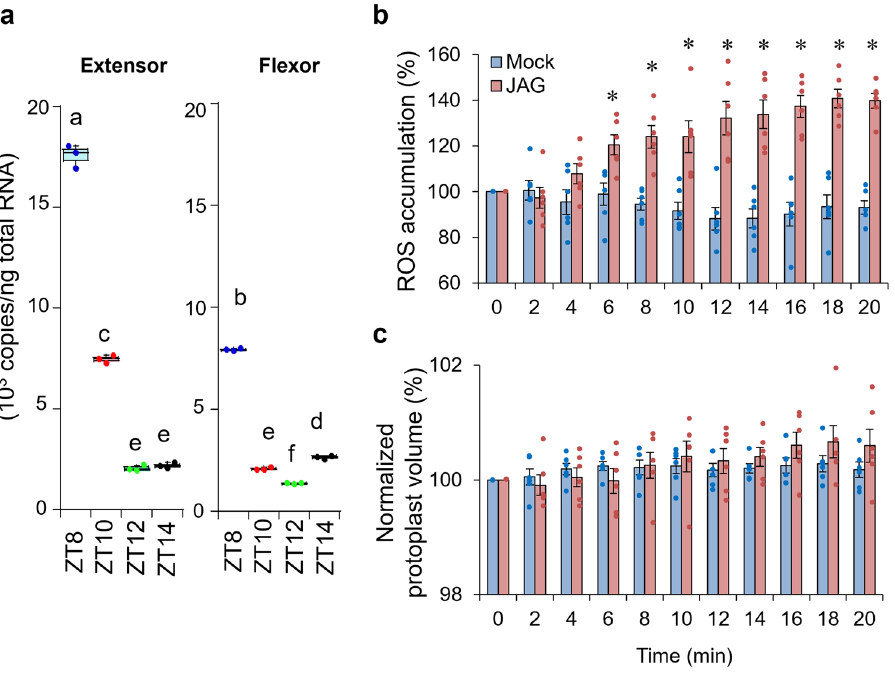
Figure 5. Effects of JAG on extensor protoplasts that did not express SPORK2. ( a ) The expression of SPORK2 gene during ZT 8–14 in extensor and flexor cells. All data points are shown as dot plots (n = 3). Different letters indicate significant differences (SNK post-hoc test, P < 0.05). ( b , c ) Time course of 12-hydroxyjasmonic acid glucoside (JAG)-induced ( b ) cytosolic ROS accumulation and ( c ) cell shrinkage in tertiary extensor protoplasts of Samanea saman during ZT 14–18. The changes in normalized cytosolic fluorescence intensity of each protoplast were expressed by considering the negative control at each given point respectively. All data points are shown as dot plots (n = 6). Asterisks indicate significant differences (* p < 0.05; t -test). Three independent experiments were